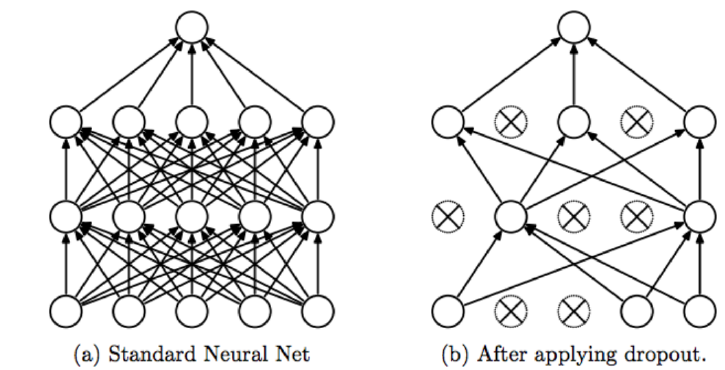
Figure 3. The difference between standard NN and Dropout NN [53]. Dropout method randomly drops units (along with their connections) from the NN during training, which prevents units from learning too much and thus potentially avoid overfitting. The dropout NN can also be seen as